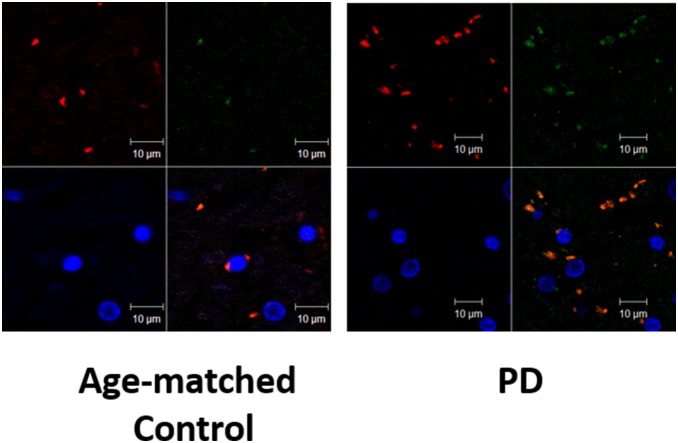
Co-localization of GPR109A and microglia in PD and control brain.Confocal microscopy image of SN of human brain samples showing the glial marker, CD11b (green) co-localized with GPR109A (red). Control sample shows less microglia and GPR109A + cells. Note that all the GPR109+ cells are not co-localized with CD11b maker in control sample. Few neuronal Nuclei (blue) are seen.